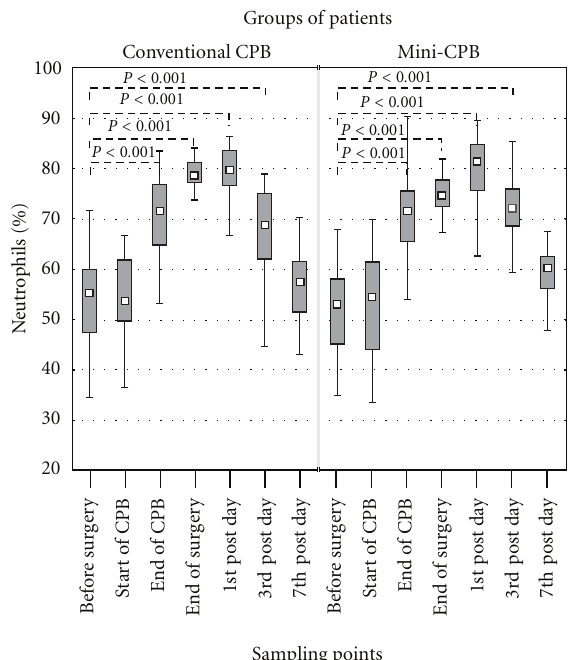
Figure 1: IL-10 level in serum of patients operated either with conventional CPB or mini-CPB. The IL-10 level was detected by ELISA. The level of IL-10 di ff ered between conventional CPB and mini-CPB group after termination of CPB ( P < 0 . 01). Even though the di ff erence at the end of surgery was not statistically significant, IL-10 greatly varied when comparing both groups. Squares display median, boxes are quartiles, and whiskers display the range of nono- utlier values.